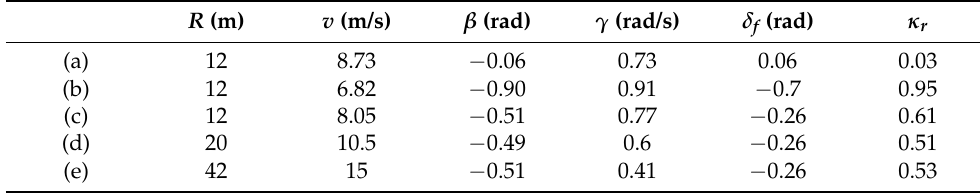
Table 2. The main state parameters of the vehicle